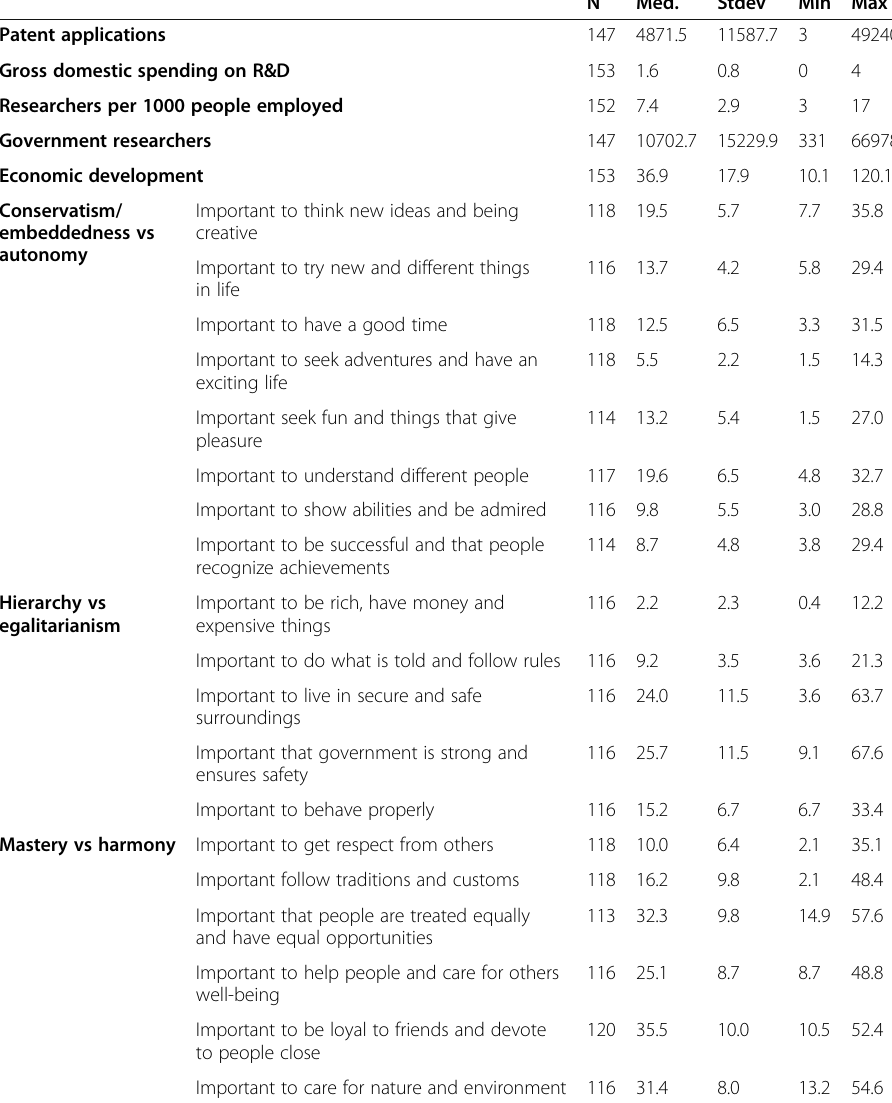
Table 2 Descriptive statistics of the variables used in the analysis Patent applications 147 4871.5 11587.7 3 49240